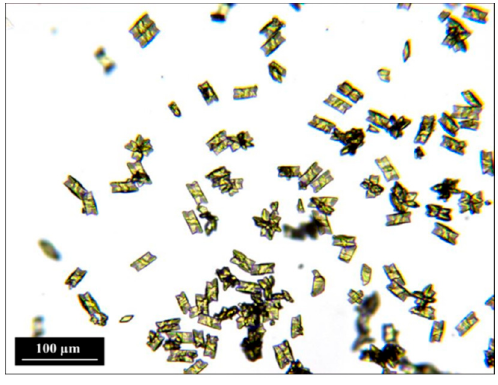
Figure 3. Monohydrate crystals produced by membrane crystallization.